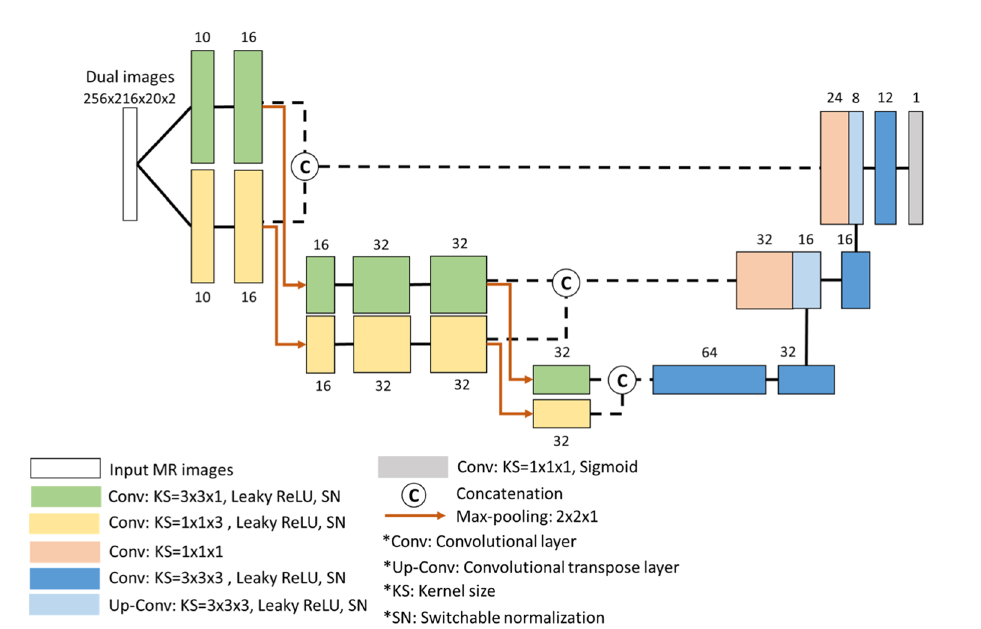
Figure 5. Architecture of proposed dual-pathway U-Net model for VS